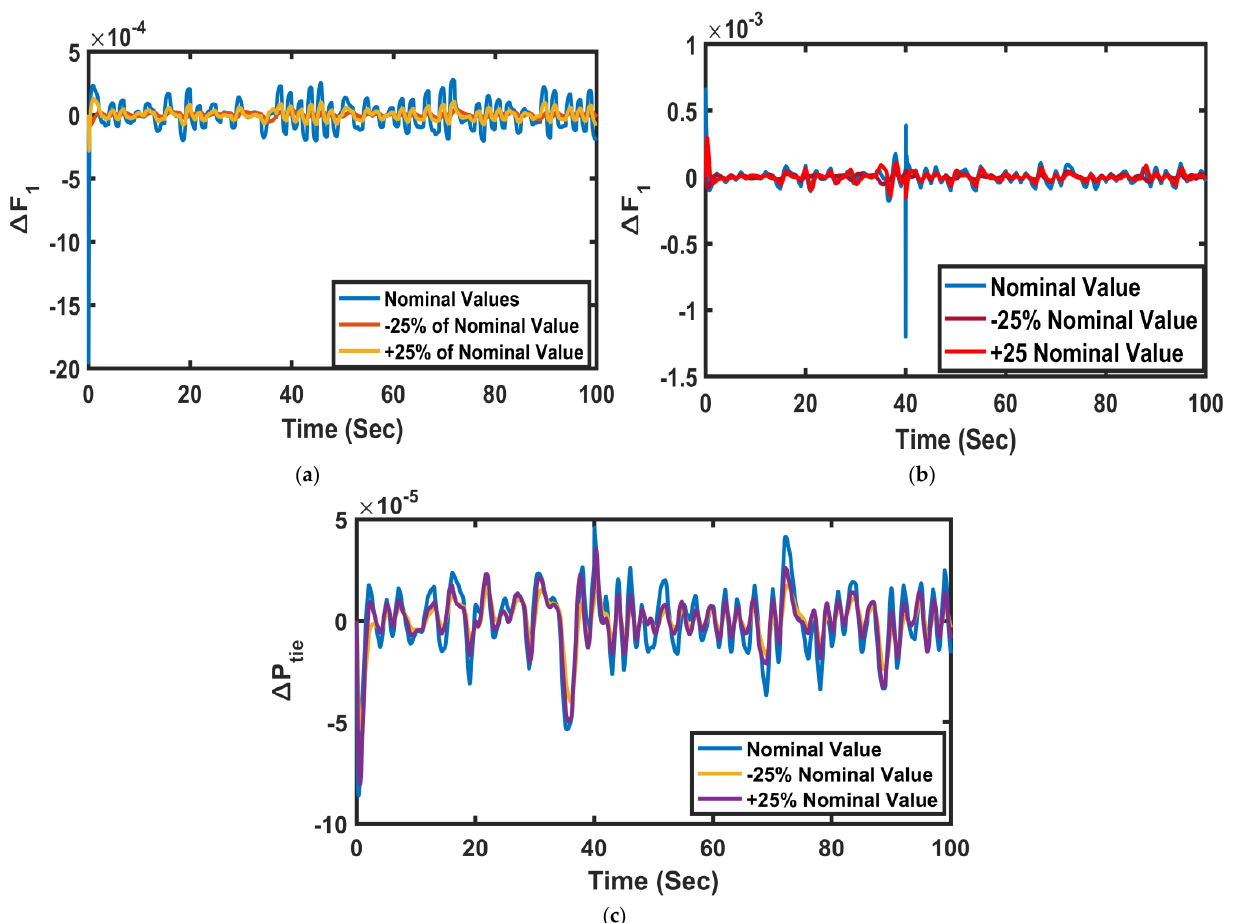
Figure 9. Dynamic Response of a system for scenario-IV: ( a ) Frequency response of area-1, ( b ) Frequency response of area-2, and ( c ) Tie-line power response.